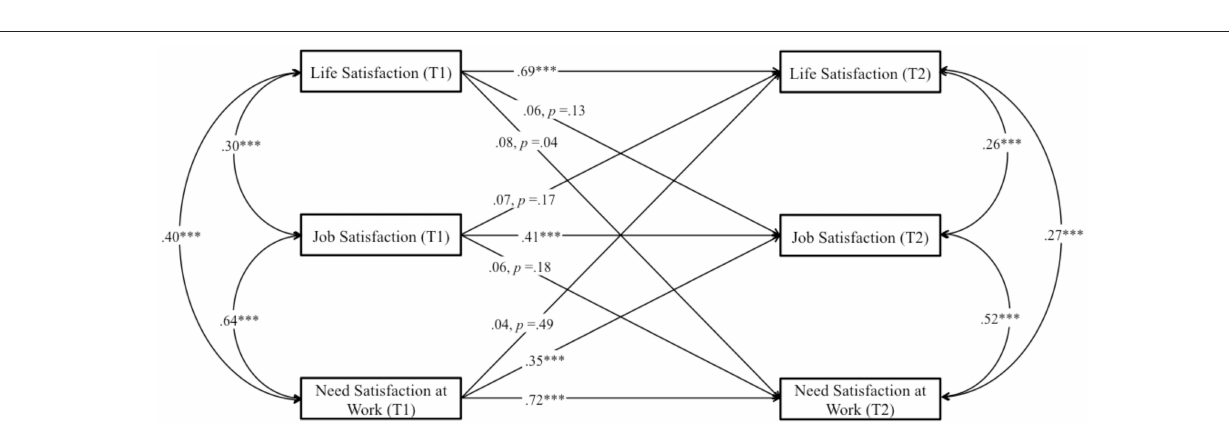
− 0.01). However, Kurtosis values for need satisfaction in life